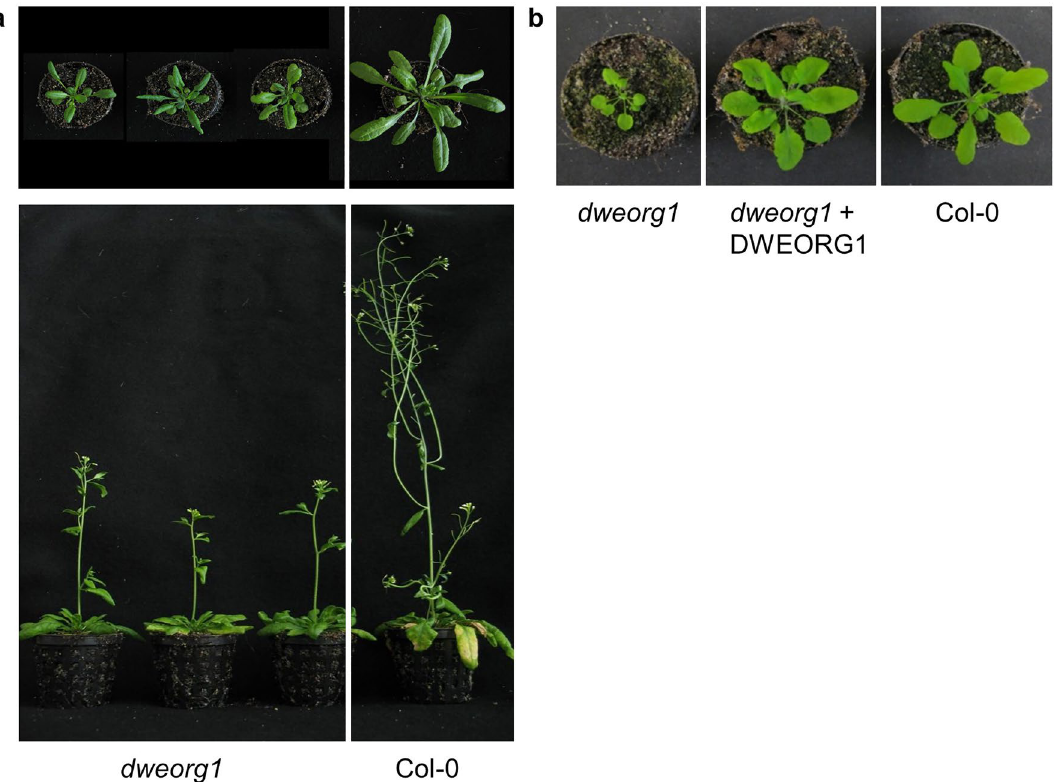
(16 h light/8 h dark; 64% humidity, 22 °C with a light intensity of 120–122 µmol*m −2 *s −1 ). ( b ) Growth comparison of wild type (Col-0) , dweorg1 , and dweorg1 -complemented with wild type DWEORG1 under the control of the CaMV 35S promoter four weeks after sowing under long-day conditions